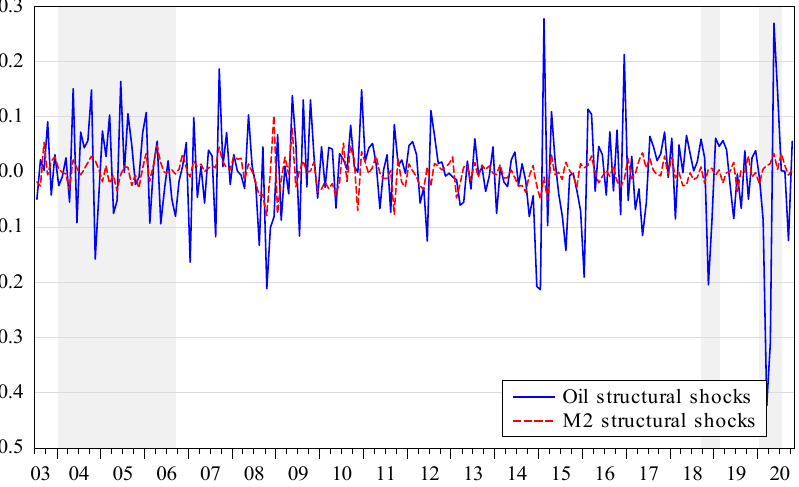
Figure 3. Identification of dynamic features of oil’s financial attribute. Note: The monetary policy in the shadow part has a negative relation with structural shocks to crude oil prices. Table 5. Stage characteristics dominated by dual attributes of oil.